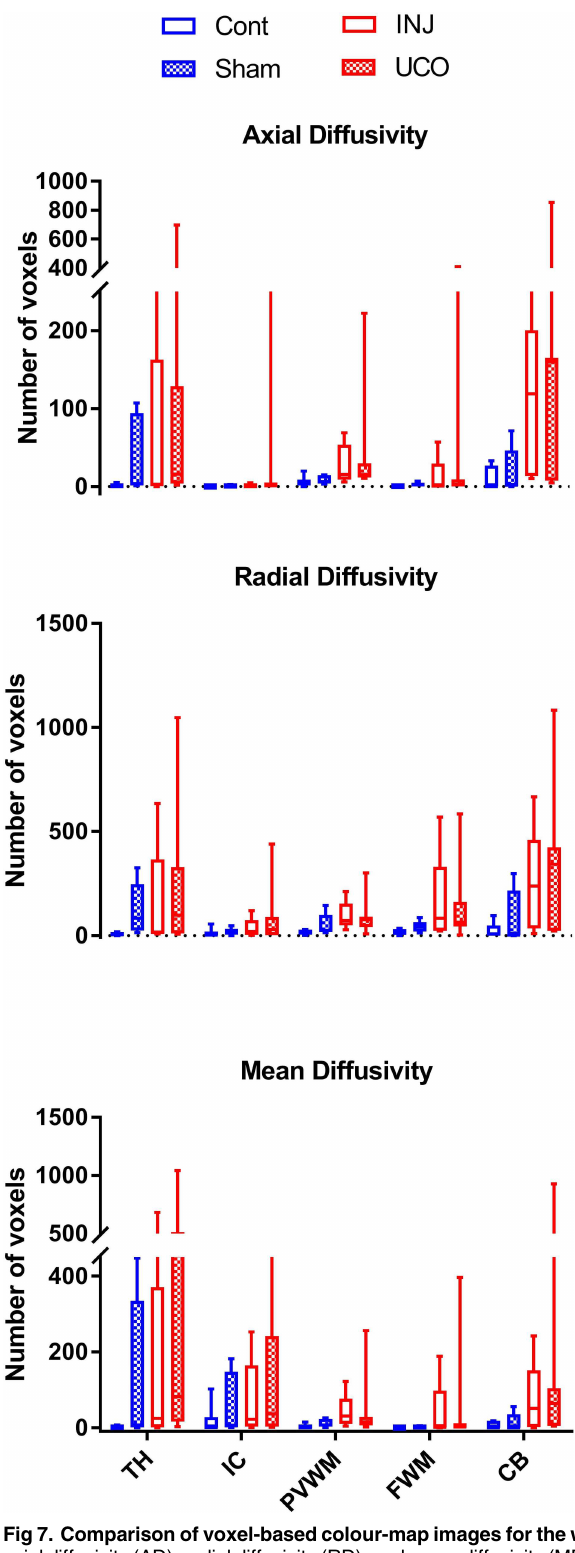
Fig 7. Comparison of voxel-basedcolour-map images for the whole brain. Images were comparedfor axial diffusivity (AD), radial diffusivity (RD), and mean diffusivity (MD) values below the thresholdfor specified regions in the lamb brain in all groups. The white matter (WM) regionswere locatedin the thalamus(Th),